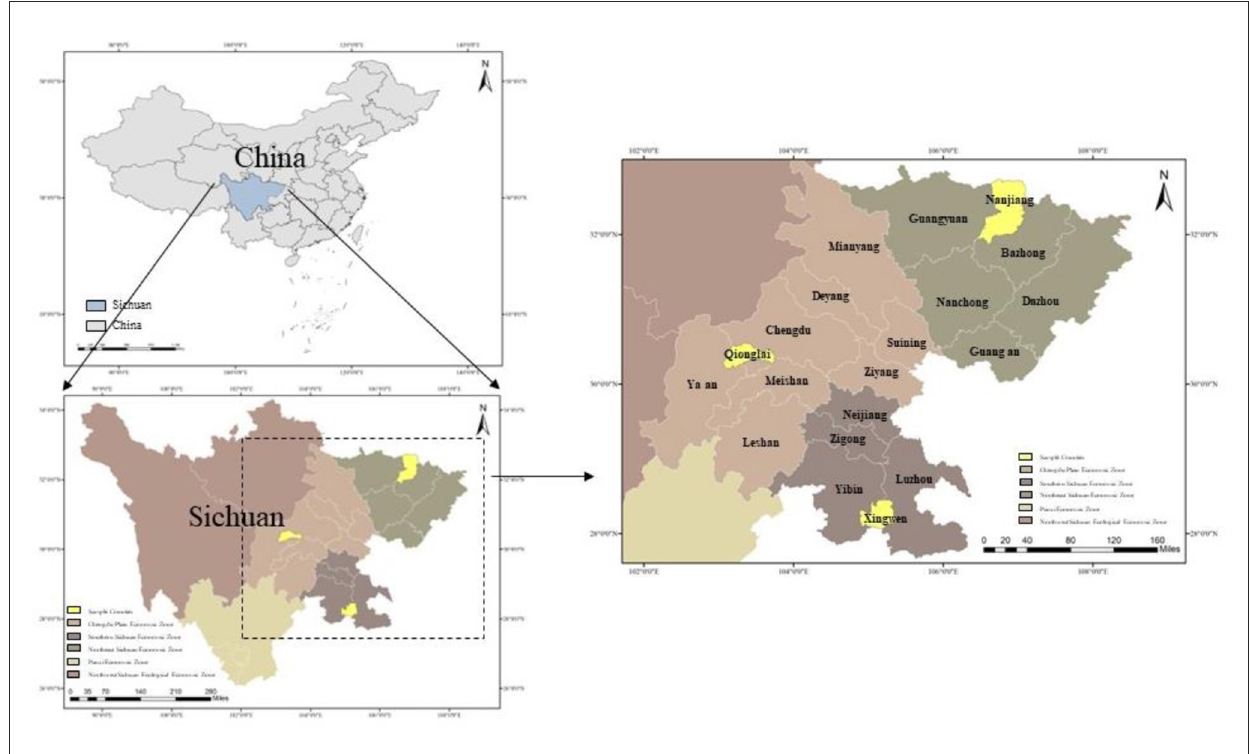
FIGURE1 Location map of sample